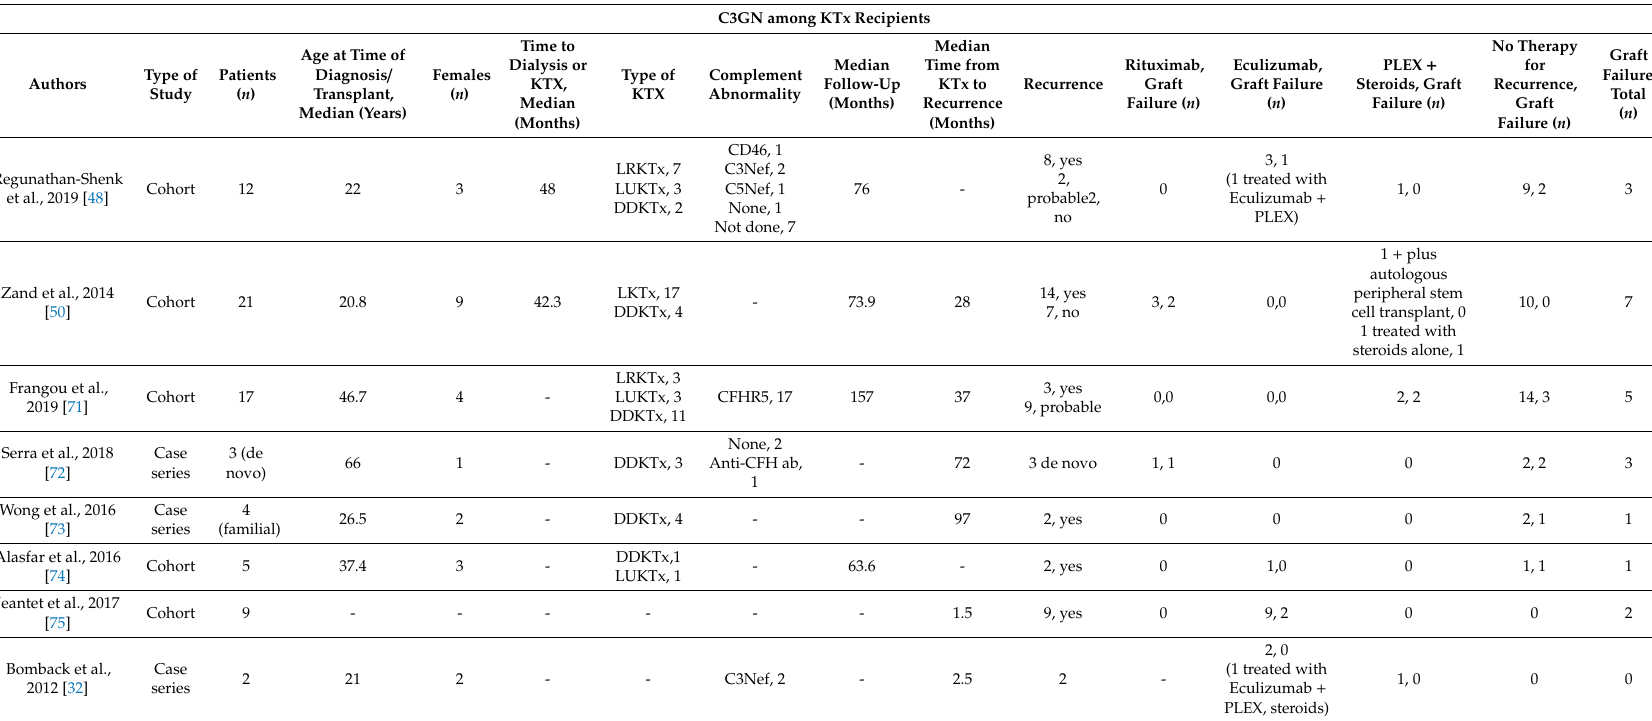
Table 1. Characteristics of the included studies in this systematic review of outcomes of KTx patients with C3GN. C3GN among KTx